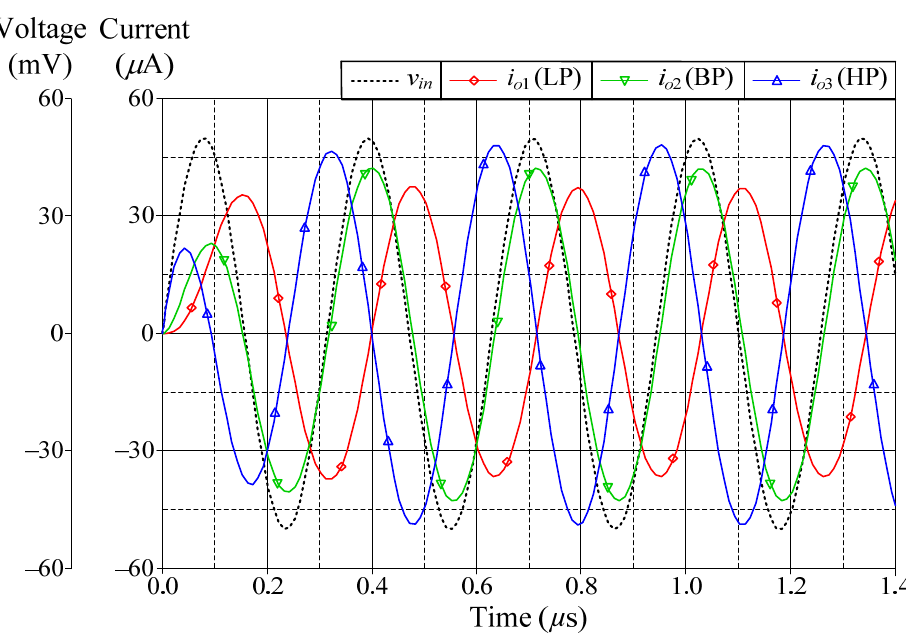
Figure 11. Time-domain responses of the LP, BP, and HP filters in CM.